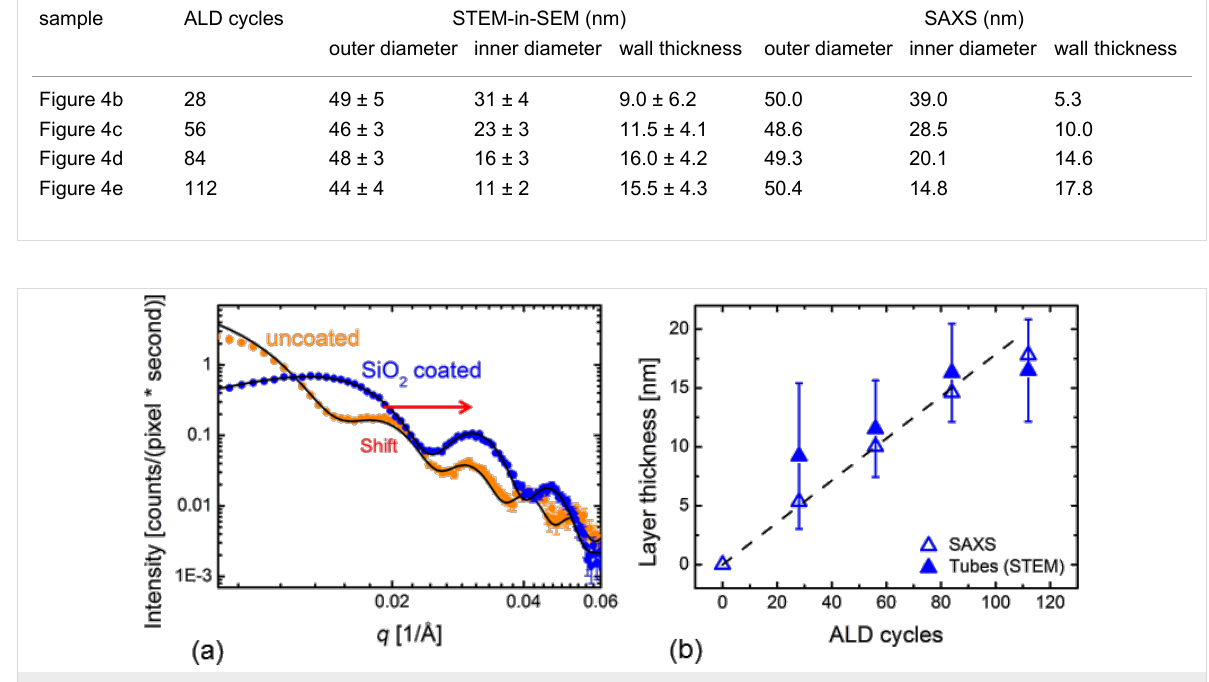
Table 3: Characteristics of SiO 2 nanotubes prepared by exposition to four different numbers of ALD cycles. Data from STEM-in-SEM images agree well with values deduced from SAXS measurements. sample